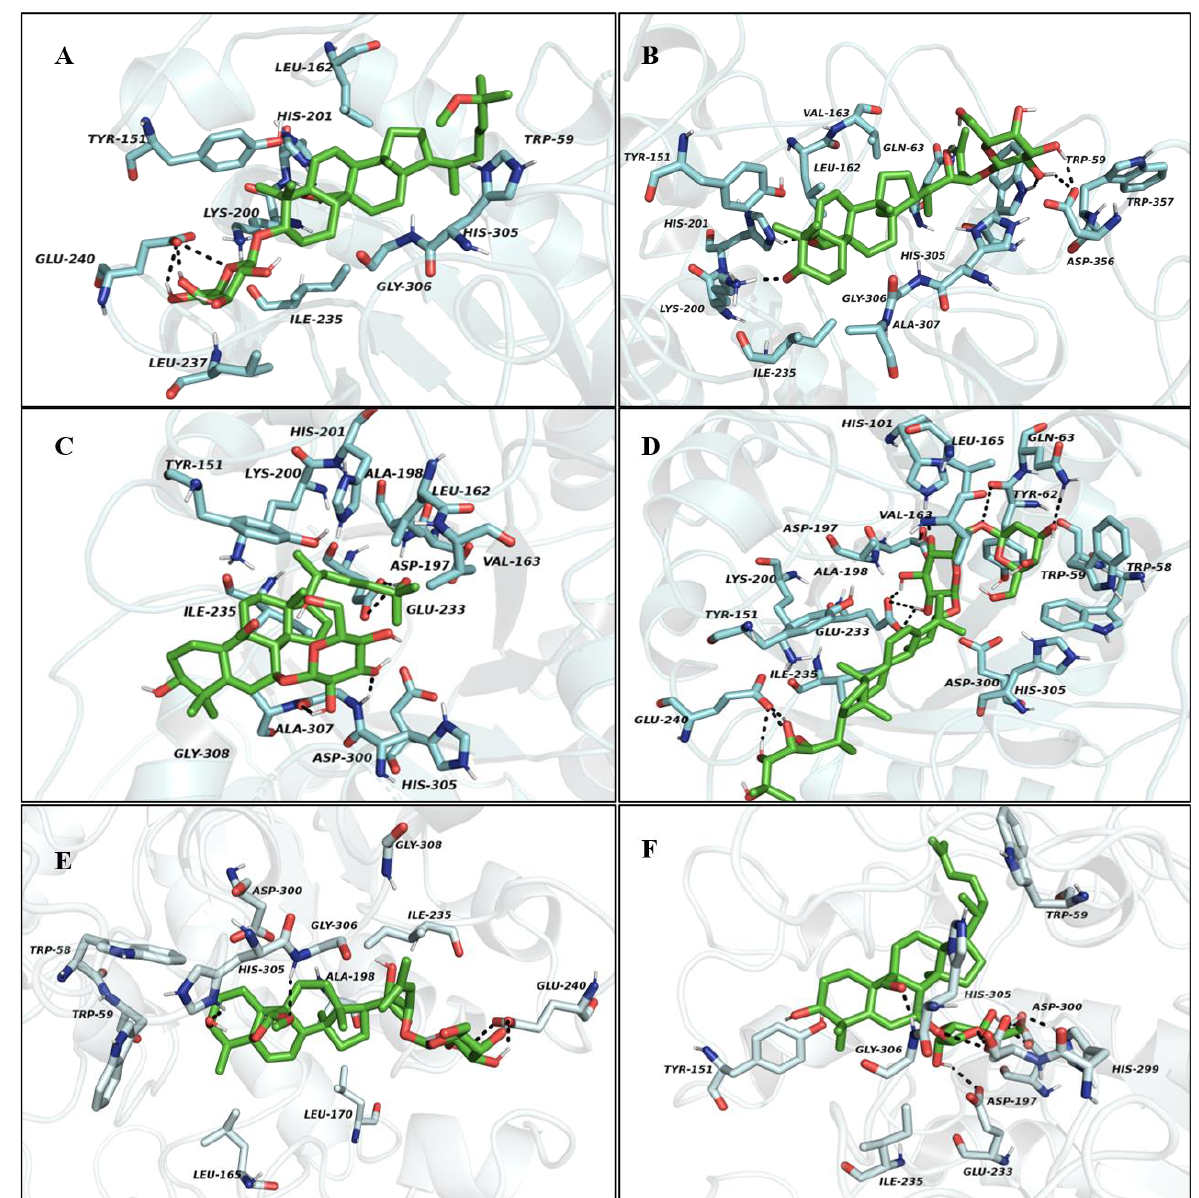
Figure 5. The 3D protein-ligand interactions for ( A ) karaviloside VI ( 2 ), ( B ) karaviloside VIII ( 3 ), ( C ) momordicoside L ( 4 ), ( D ) momordicoside A ( 5 ), ( E ) Charantoside XV ( 6 ), and ( F ) kuguaglycoside C ( 7 ) in the binding sites of α -amylase. Black dotted lines indicate hydrogen bonds between compounds and amino acid residues. Ligands in the active sites are denoted in green color. Active site residues are shown in cyans color.